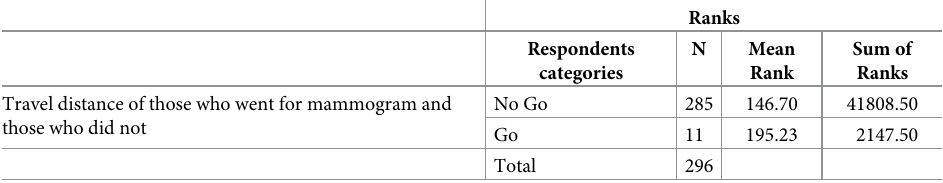
Ranks Respondents N Mean Sum of categories Rank Ranks No Go 285